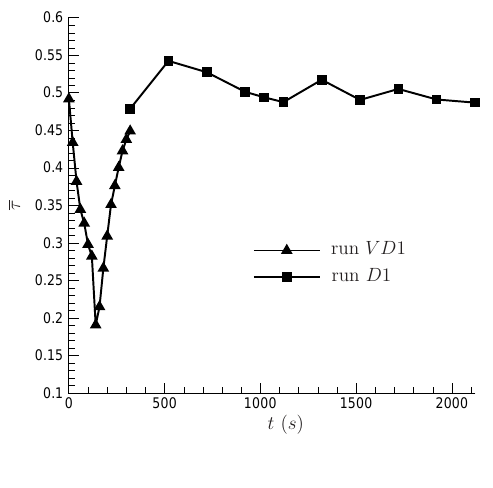
and D 1 (dissipation regime), from t = 0 to t = 2120s.